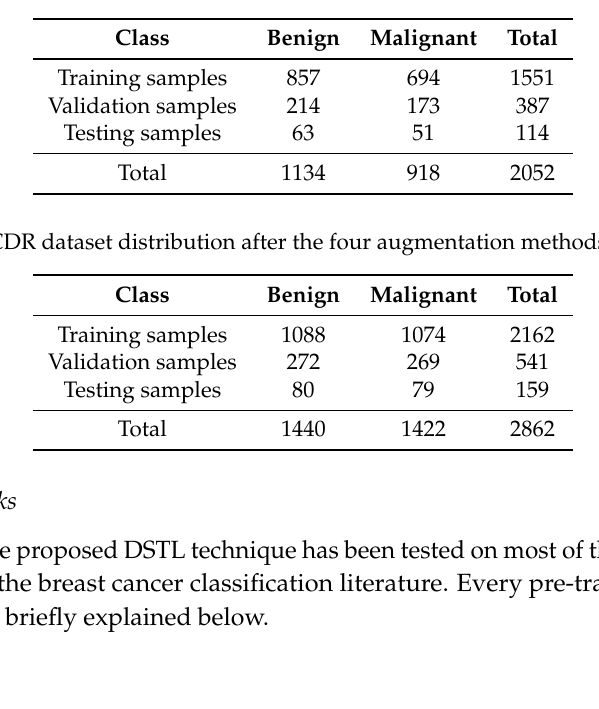
Table 3. MIAS dataset distribution after the four augmentation methods combined.